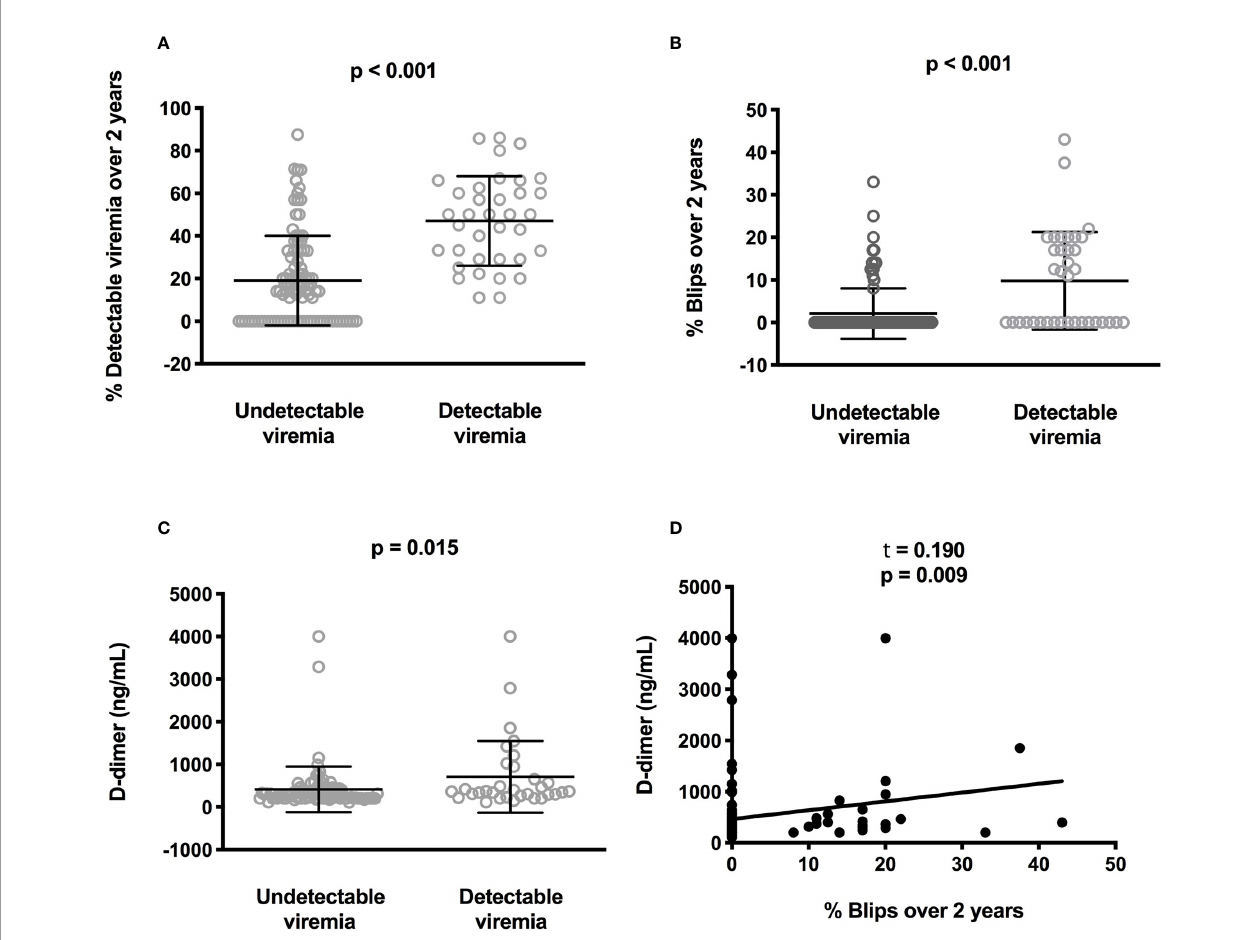
FIGURE 1 | Correlations between low-level viremia, blips, and D-dimer plasma levels. Difference for each participant in the frequency where the participant displayed low-level viremia (A) or blips (B) over the two last years between participants with or without current detectable viremia. Difference in circulating D-dimer concentrations between participants with or without current detectable viremia. Statistical analyses were performed using a Mann-Whitney test (C) . Correlation between the frequency of blips over the two last years and D-dimer plasma levels. Statistical analysis was performed using Kendall correlation (D)